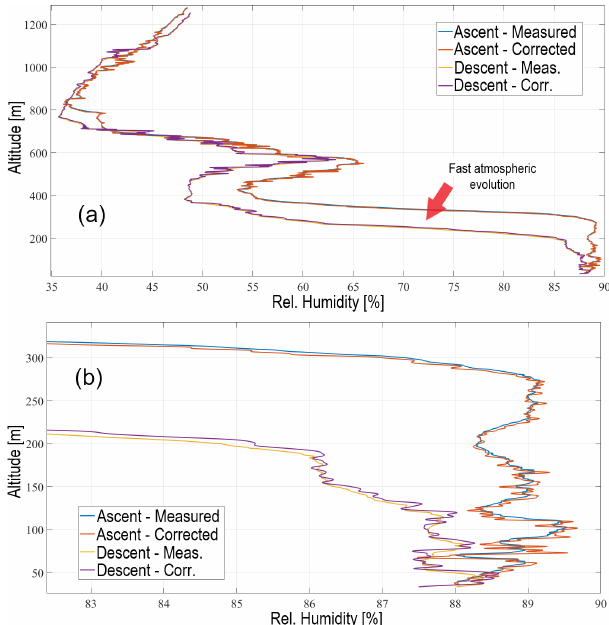
Figure 13. (a) Relative humidity vertical profile measured against corrected values. (b) Close-up of the vertical profile in the lower altitude